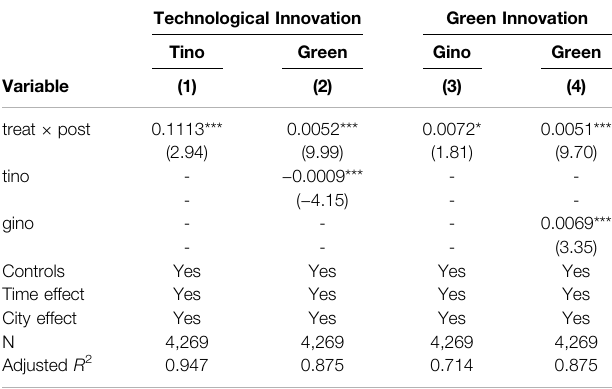
TABLE 7 | Mechanism test results based on technological innovation and green